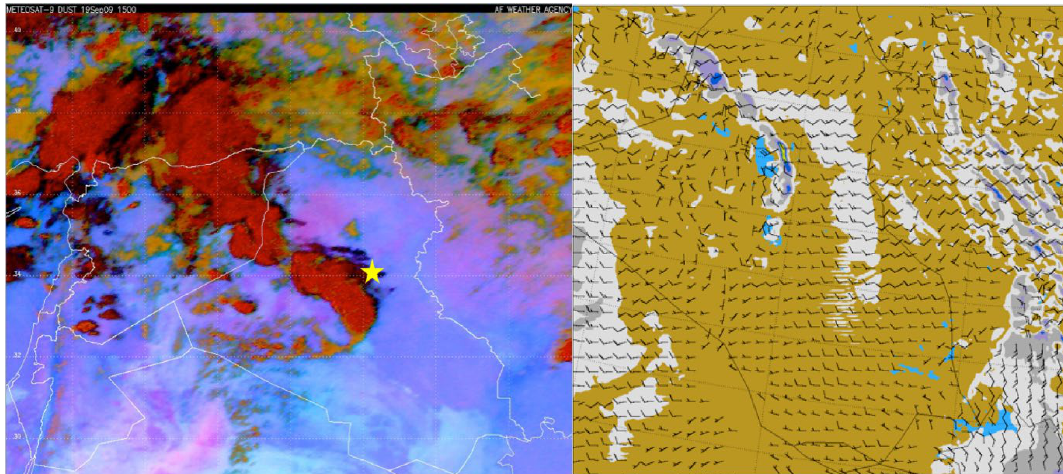
Figure 9. ( Left ): Dust enhanced infrared satellite from METEOSAT-9 valid 1500 UTC on 19 September 2009. Balad Air Force Base noted with the yellow star. ( Right ): Sustained wind speed forecast from member 1 of the 1800 UTC 18 September 2009 4-km regional ensemble valid at 1500 UTC on 19 September 2009. Light gray is 10–15 knots, dark gray is 15–20 knots, light purple is 20–25 knots, blue is 25–30 knots, green is 30–35 knots, and yellow is 35–40 knots.